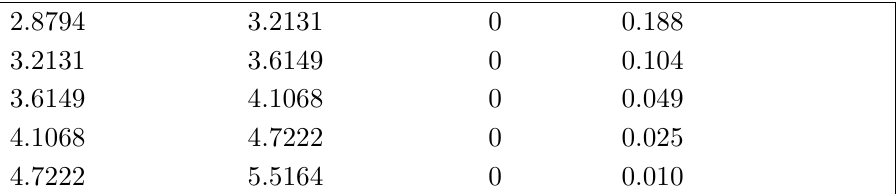
Table 11. Expected and observed event yields in the dimuon channel, directly corresponding to the non-linear binning presented in (cid:12)gure 3b. The expected yield is given up to at most 4 digit